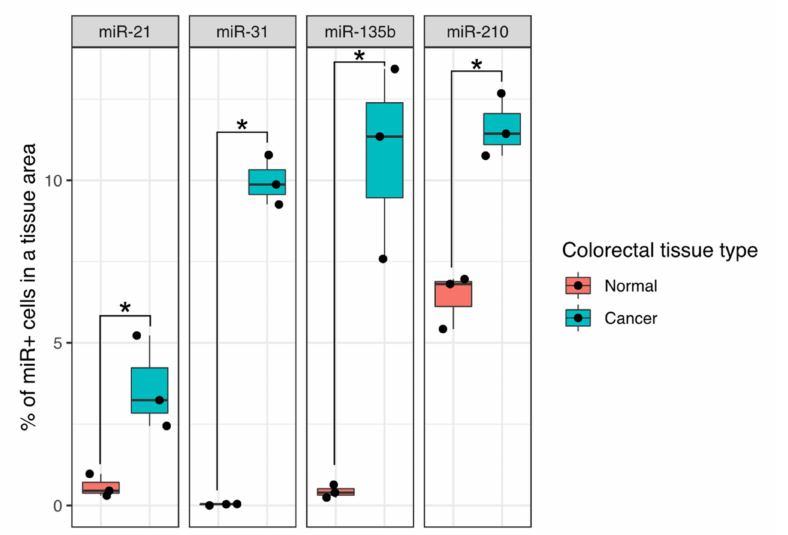
Figure 9. Quantification of the fraction of miR+ cells in normal and colorectal carcinoma human tissues in which FISH was done for four miRNAs that have been shown to be significant players in metastasis. Percentage values shown are with respect to the total cell number in a 20 × magnification field of view. Unpaired one-sided Wilcoxon, * p ≤